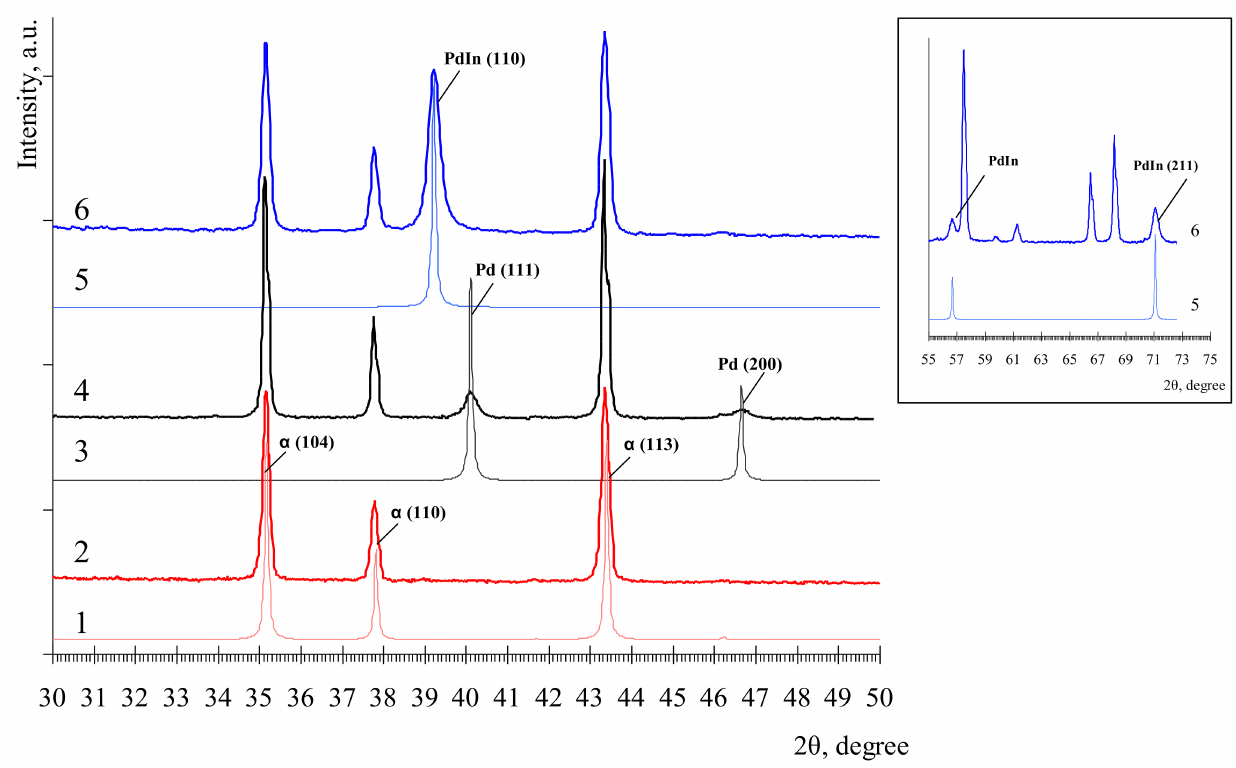
Figure 1. Powder X-ray diffraction patterns of α -Al 2 O 3 (2), Pd/ α -Al 2 O 3 (4), and Pd-In/ α -Al 2 O 3 (6). The reference XRD patterns from PDF-4 2018 are also displayed (1, 3 and 5, respectively). Inset represents an additional set of XRD signals attributed to PdIn IMCs at 2q > 55 ◦